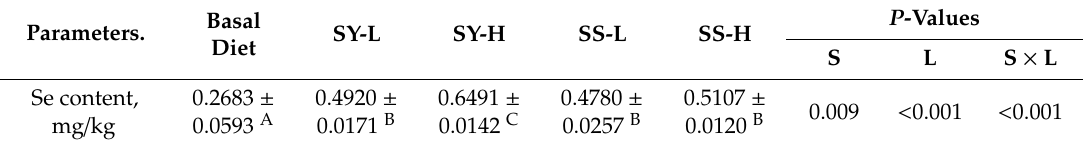
Table 4. E ff ects of dietary supplementation of di ff erent selenium sources and levels on egg selenium content of laying hens.